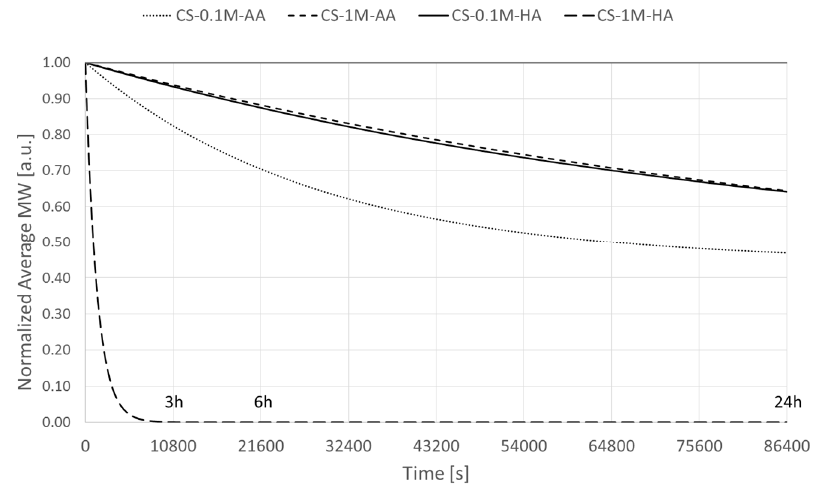
Figure 8. Normalized values of molecular weight over 24 h (86,400 s) time 2% chitosan solution with different solvent types and concentrations (please refer to Table 1 for sample coding) at 80 °C.